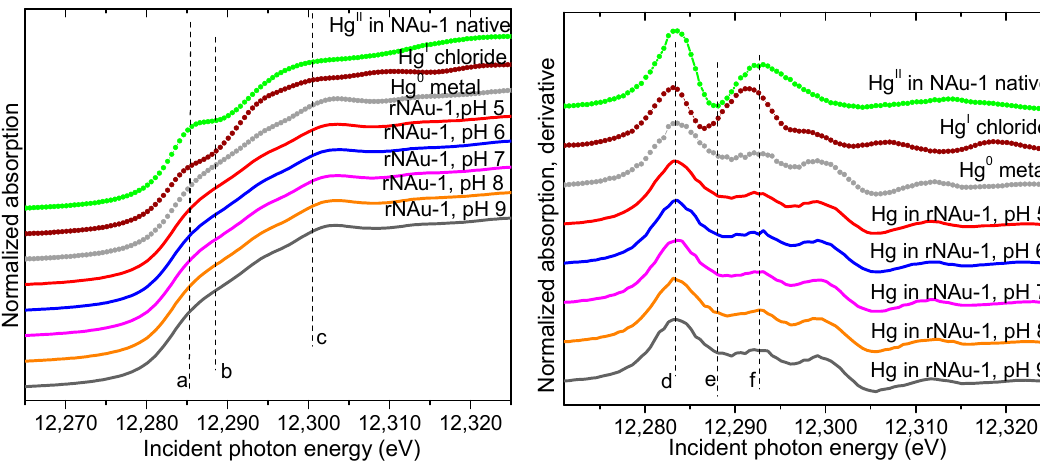
Figure 4. Hg L III -edge XANES spectra ( left ) and derivative ( right ) from the solids in the rNAu-1 systems at pH 5–9 compared to standards (symbols). The vertical dashed lines (a–f) are a guide to the eye, delineating features corresponding to the different valence states of Hg.